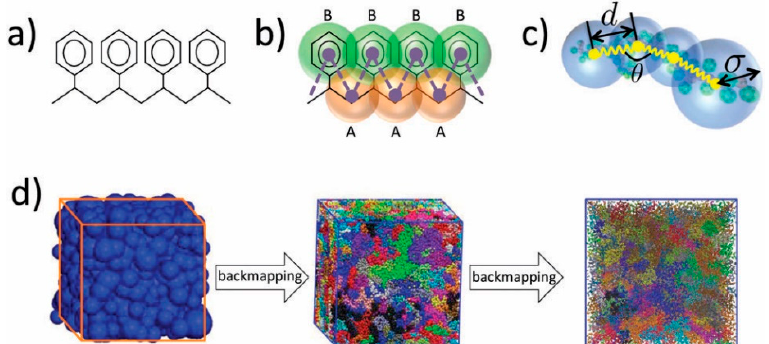
Figure 6. Depiction of a hierarchical backmapping corresponding to ( a ) a united atom representation, ( b ) a moderate CG model consisting of beads of types A and B, and ( c ) a blob-based representation of soft spheres by lumping together a number of beads of representation ( b ). The backmapping procedure is described in ( d ) for the three resolutions. Reproduced with permission from [161] .